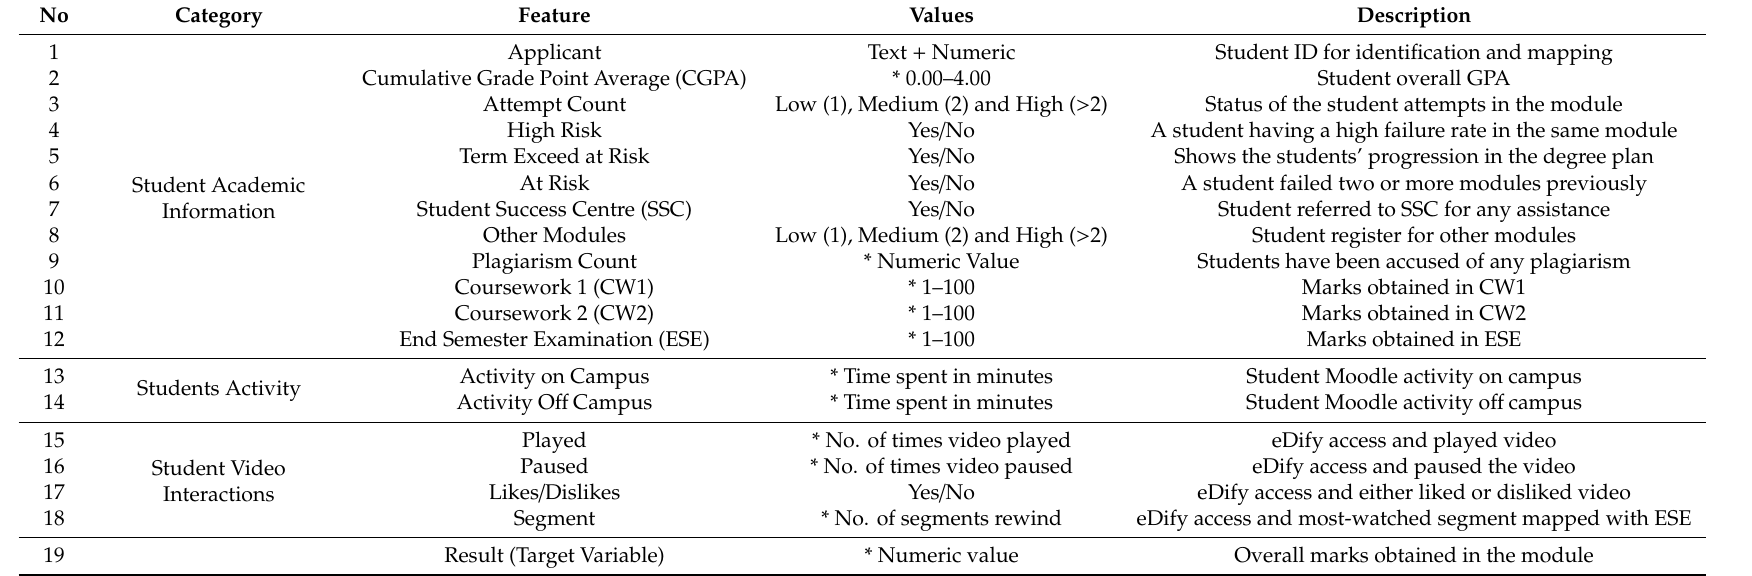
Table 1. List of extracted features and description. GPA: grade point